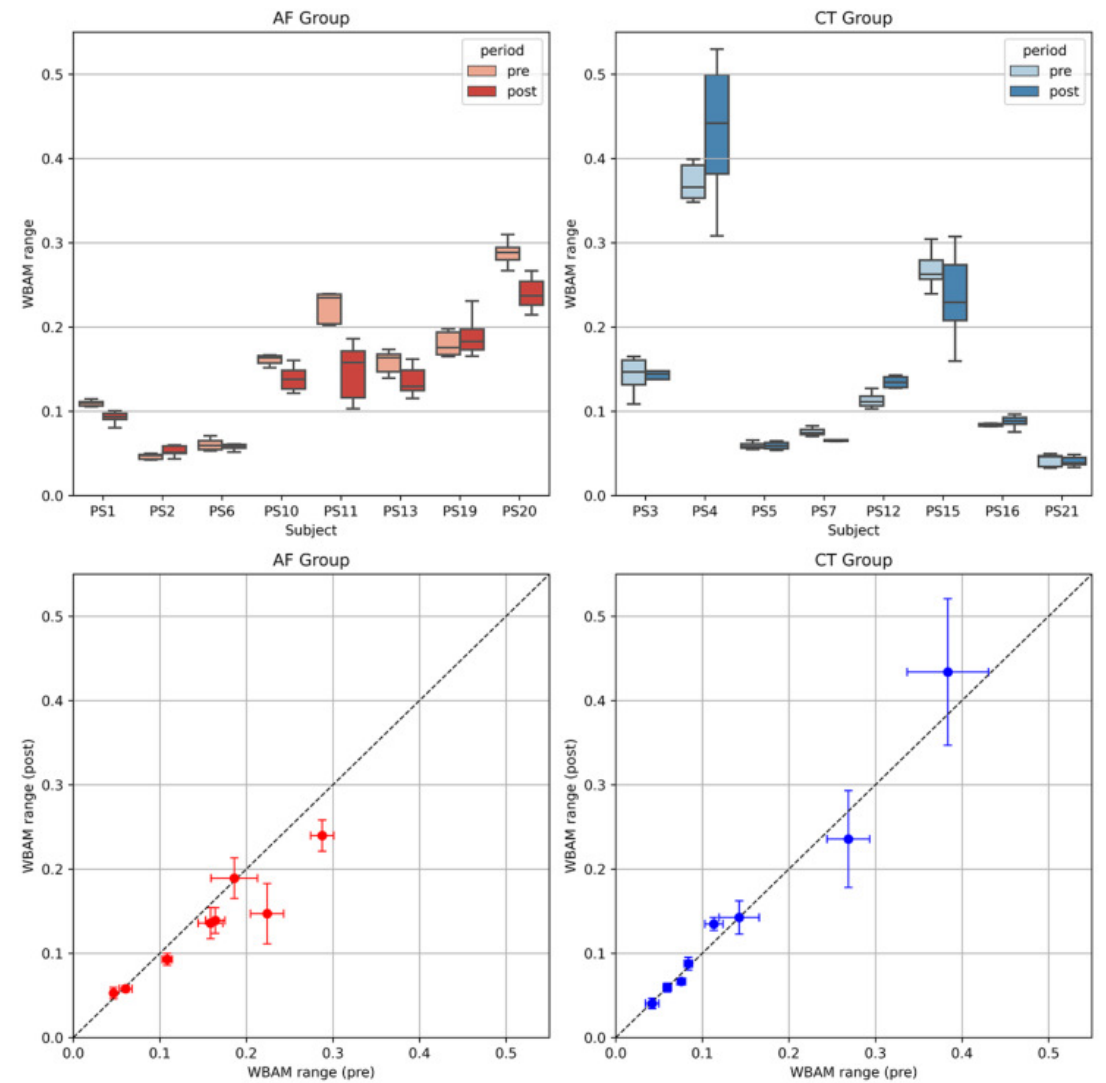
Figure 4. Frontal WBRA range on the pre and post conditions of two-week rehabilitation. The left and right panels show the AF and CT groups, respectively. The upper panels show boxplots of the changes in the pre and post conditions for each patient (including more than five gait cycles). The lower panels plot the mean and S.D. in the precondition on the horizontal axis and the postcondition on the vertical axis (pre–post plot of WBAM range). Each dot in the graphs represents the data = L pre for each patient. The black-dot lines indicate L post , which indicates that there is no change in the pre and WBAM r WBAM r post